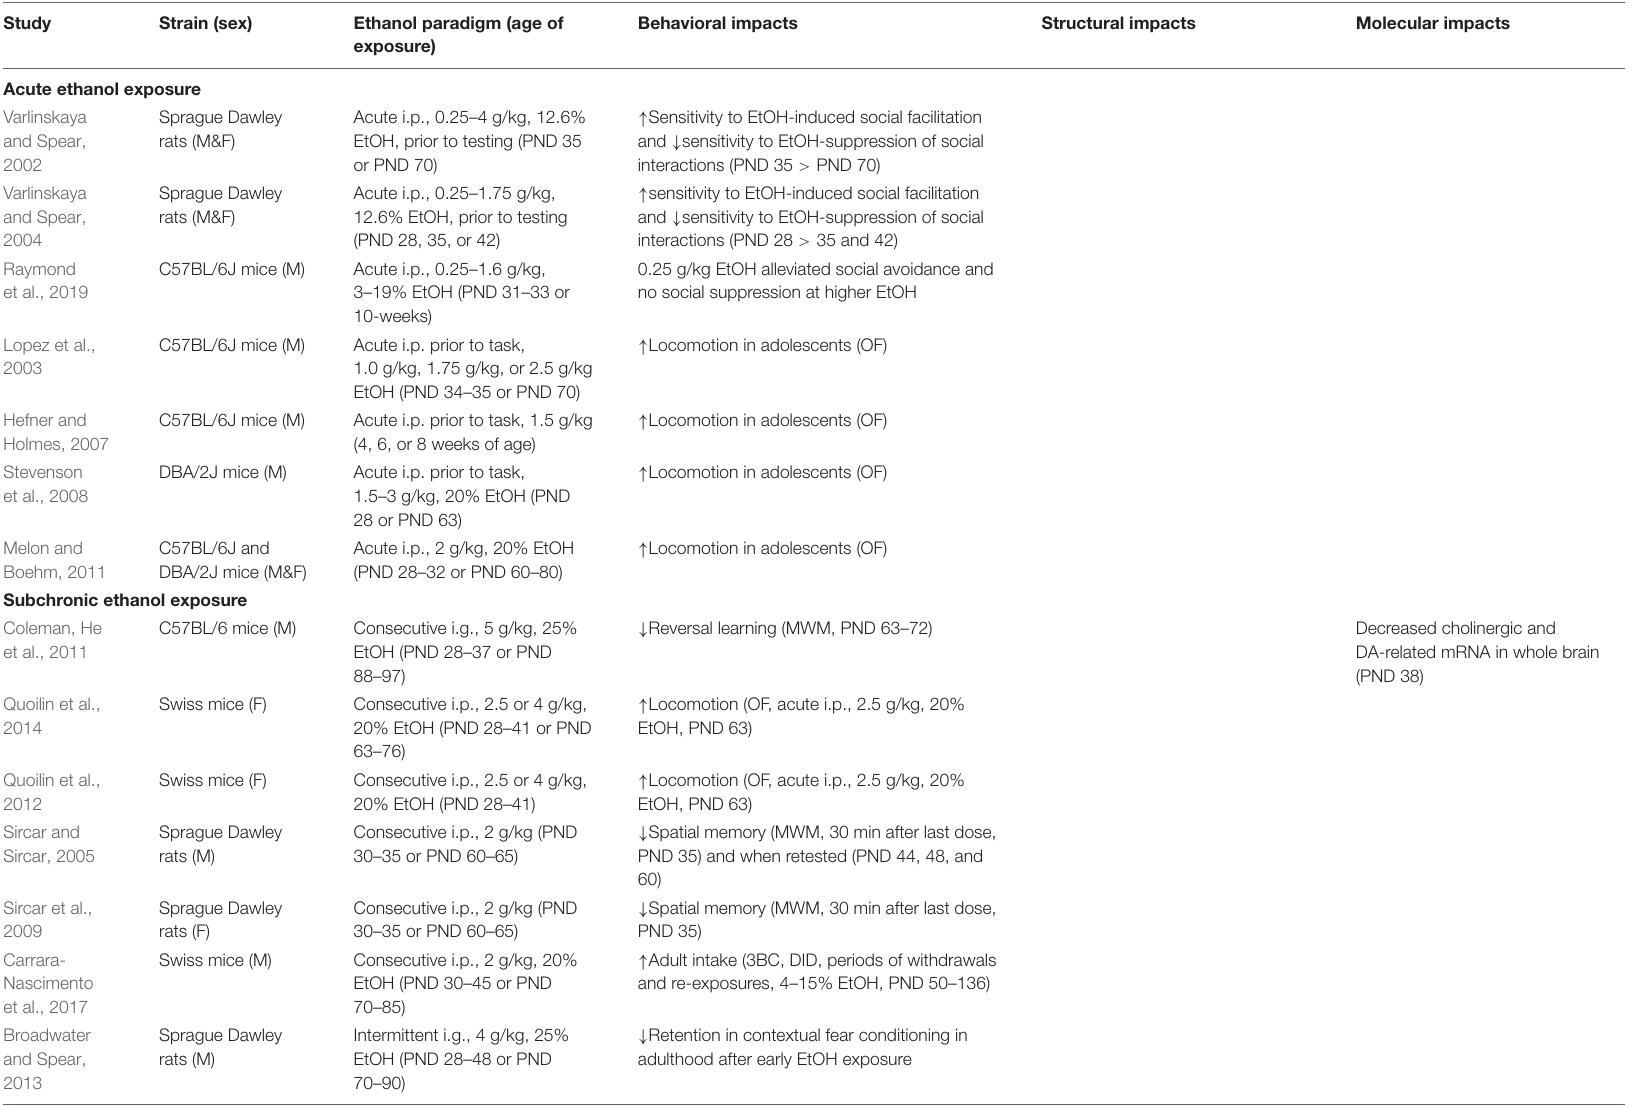
TABLE 2 | Behavioral, structural, and molecular impacts following adolescent ethanol